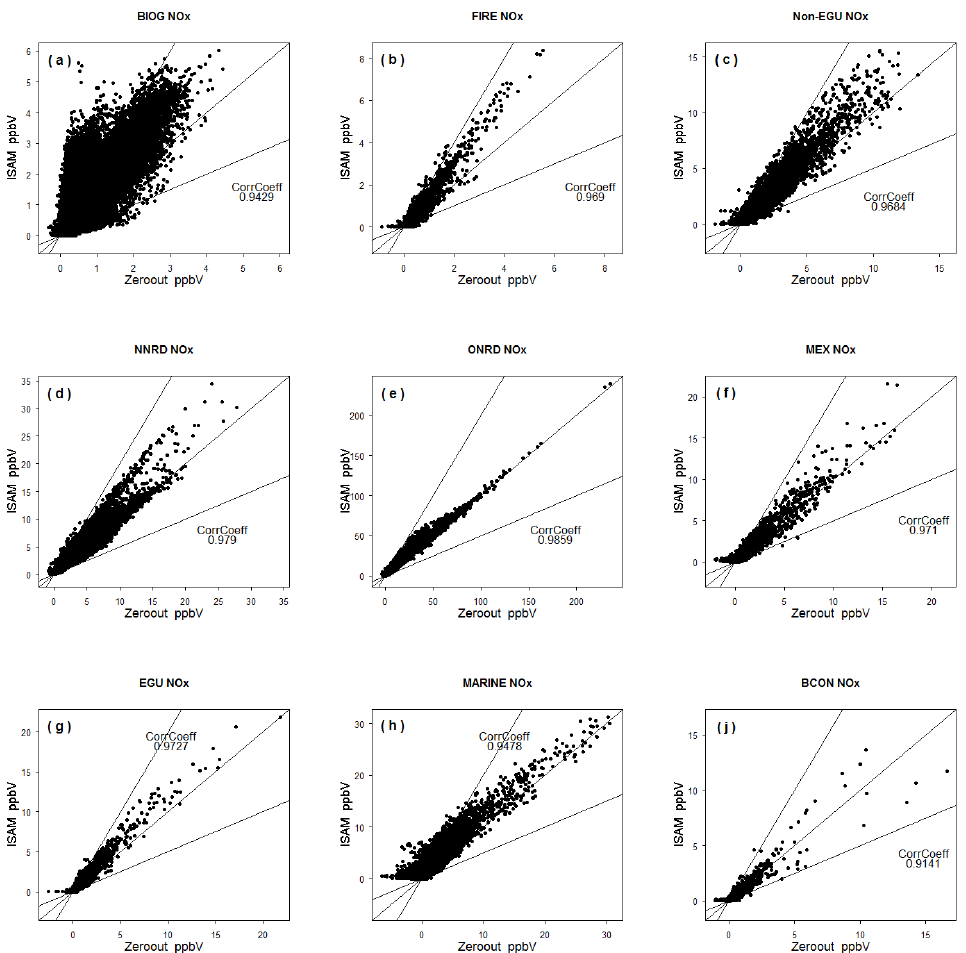
Figure 6. ISAM/N-out NO x (NO + NO 2 ) comparison for each sector and all simulated hours. The sectors are (a) biogenic BIOG, (b) wild- fires FIRE, (c) non-electricity generation units Non-EGU, (d) non-road mobile NNRD, (e) on-road mobile ONRD, (f) other point sources MEX, (g) electricity generation units EGU, (h) marine MARINE, and (j) boundary conditions BCON. Note different scales across the